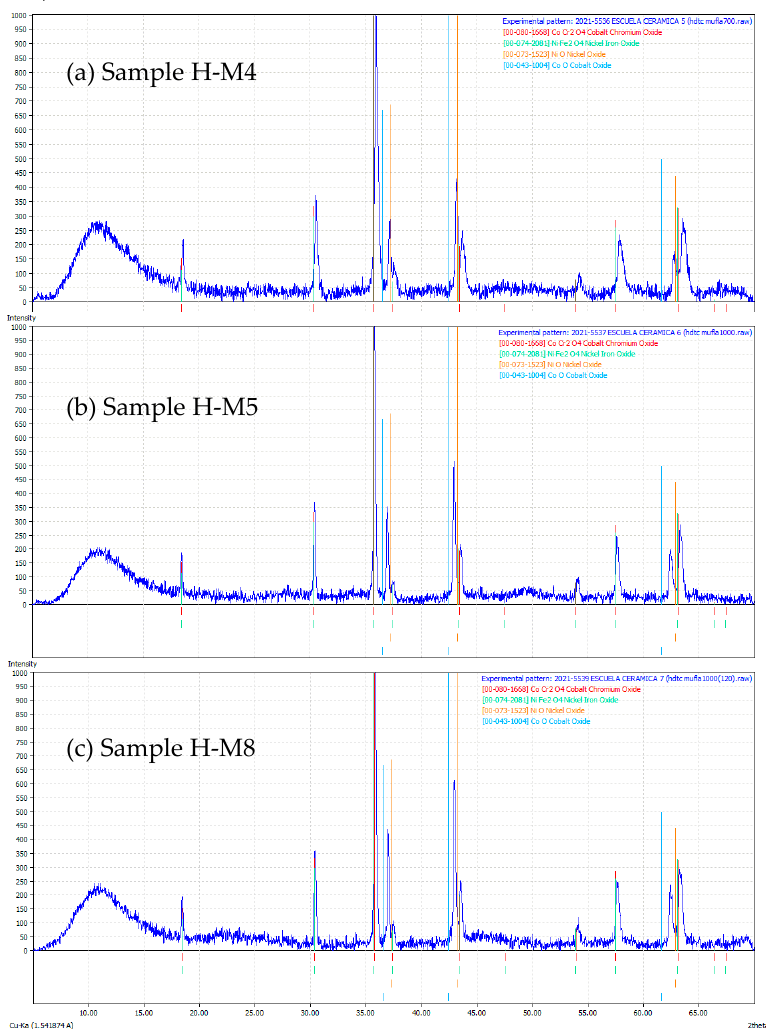
Figure 8. XRD patterns of samples H-M4 ( a ), H-M5 ( b ) and H-M8 ( c ) (red lines correspond to CoCr 2 O 4 XRD pattern (JCDPS 0801668), light green to NiFe 2 O 4 (JCDPS 0742081), and orange to NiO (JCDPS 0731523)).